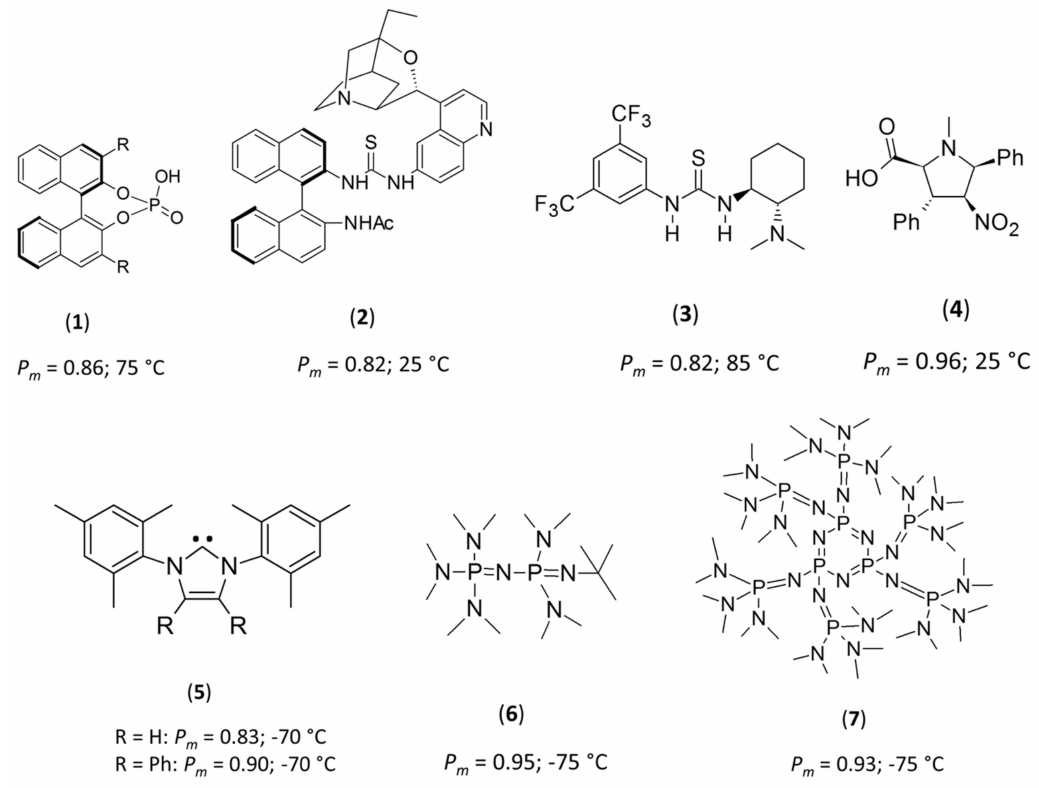
Figure 1. Structures of chiral and achiral catalysts employed for the stereoselective ring-opening polymerization (ROP) of rac